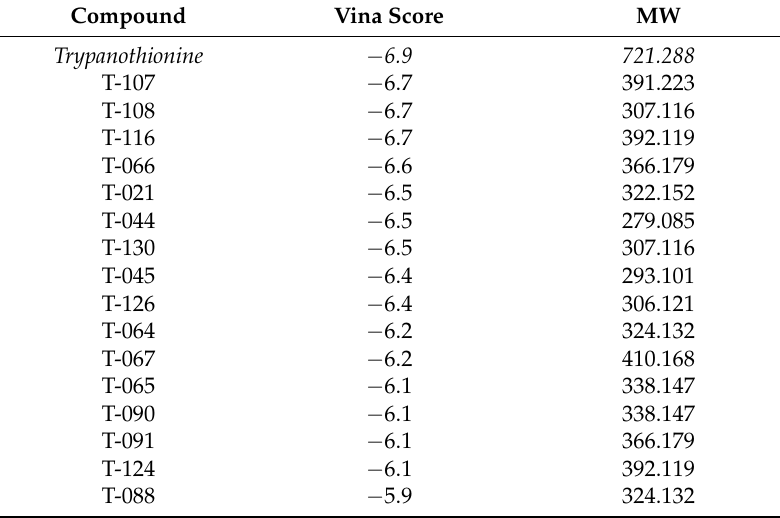
Figure 1. 2D visualization of the compound T-085 docked on the binding pocket of TR (PDB ID: 1BZL). Red lines represent hydrophobic interaction of non-ligand residues, green dashed lines represents hydrogen amino acid-ligand interaction and its length, black balls joined with blue balls represent ligand bonds, green balls represents the 3F atoms. The plot was created with LigPlot + software [28].